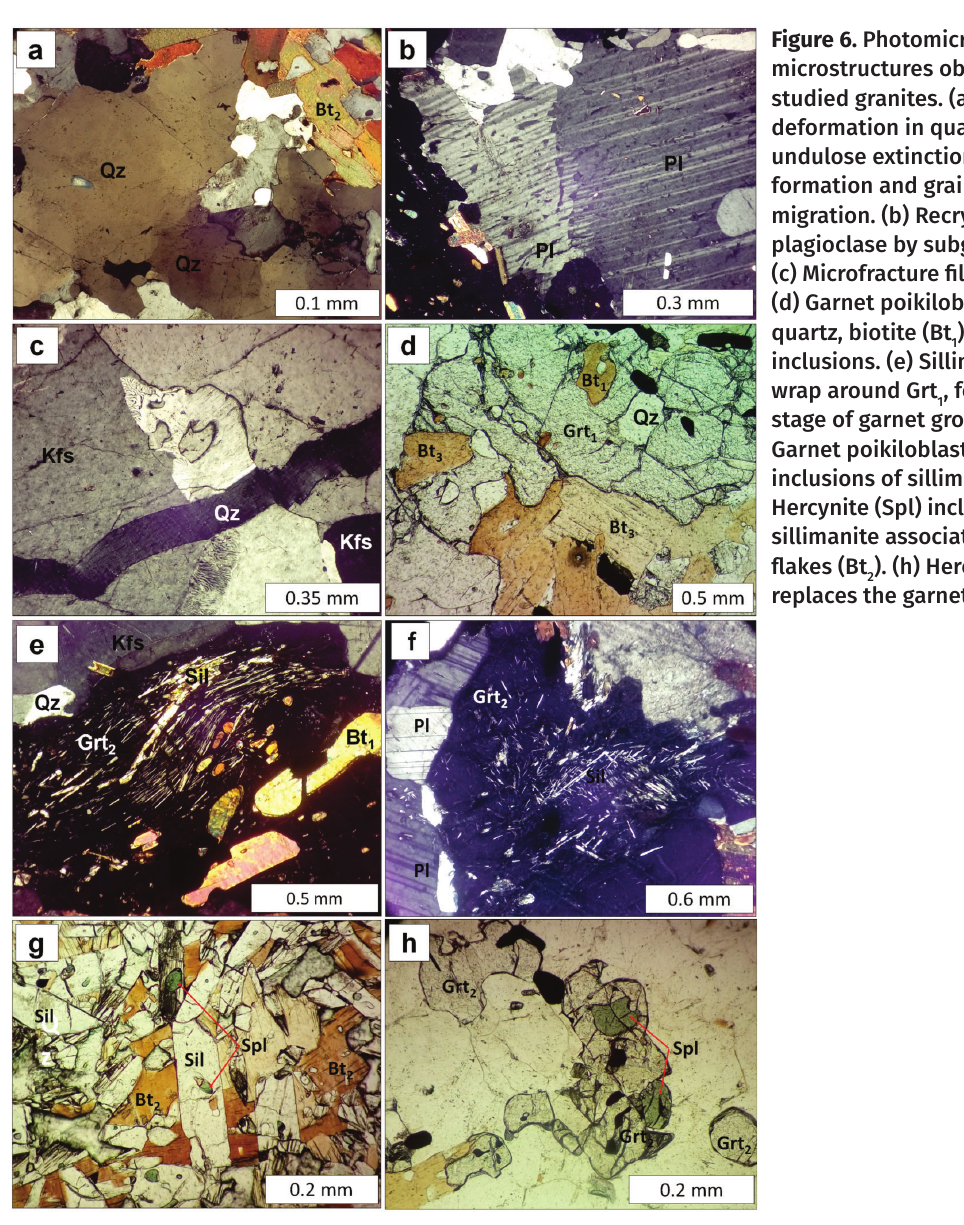
associate to the M event. Considering pressures garnet-sillimanite-quartz-plagioclase (GASP) 2 of 7-10 kbar, estimates geothermometric geobarometer. Calculated peak pressures are indicates equilibrium conditions at 633-643 around 5.4-8.5 kbar (CCS-21) and 5.2-8.2 kbar event °C (CCS-21) and 736-746 °C for the M (CCS-25) at temperatures between 700 and 1 (Table VI). Temperatures around 757-775 °C 900 °C (Table VI). Retrograde re-equilibrium (CCS-21) and 718-735 °C (CCS-25) were attained indicates lower temperature of about 600-609 event (Table VI). Estimate during the M °C (CCS-21) and 665-664 °C (CCS-25) at pressures 2 pressures of the peak metamorphic of the of 4-6 kbar (Table VI). event have been determined using the M 2